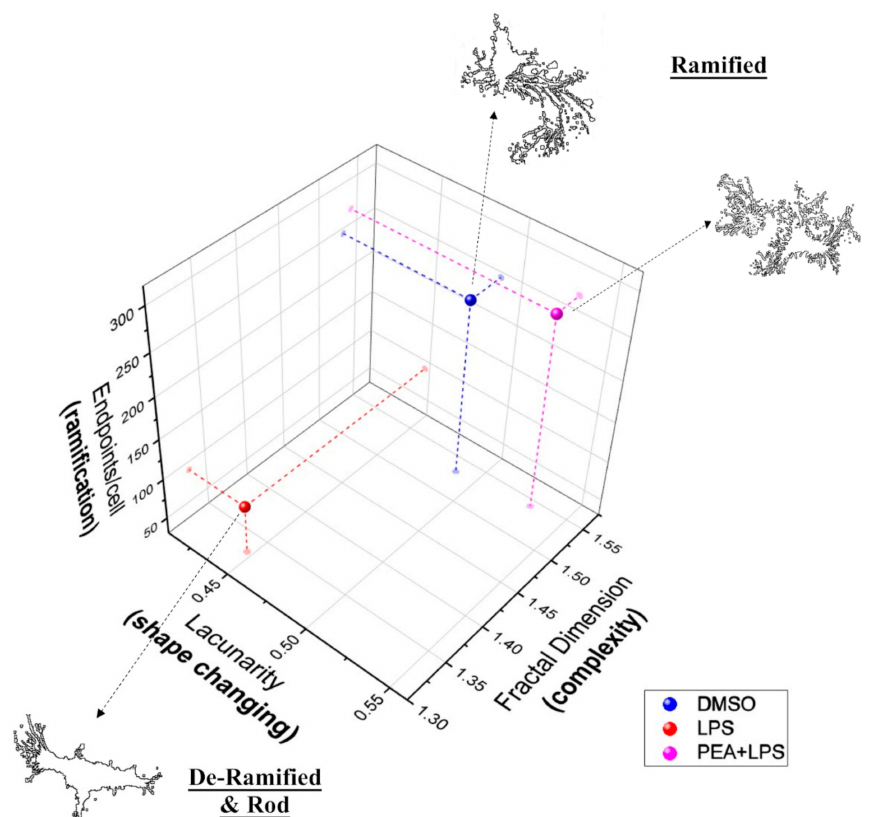
Figure 7. Effect of PEA on different microglia morphologies in LPS-stimulated N9 cells. Fractal dimension (D B ), end- points/cell, and lacunarity data were analyzed by Pearson’s correlation and then averages for each group were used for visualization. The figure summarizes the relationship between all three variables. Fractal dimension (D B ) is directly related to endpoints/cell ( r = 0.9994, p = 0.0108) and lacunarity ( Λ ) ( r = 0.2637, p = 0.06954); lacunarity ( Λ ) is not significantly correlated with endpoints/cells ( r = 0.9161, p = 0.1313). Two groupings emerge: ramified and de-ramified and